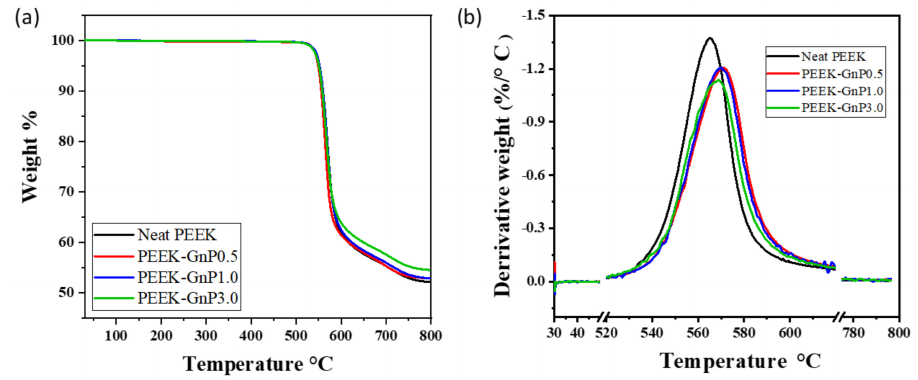
Figure 6. Thermogravimetric analysis, ( a ) TGA and ( b ) DTGA, of the neat PEEK and PEEK filled with 0.5, 1.0, and 3.0 wt.% of GnPs.